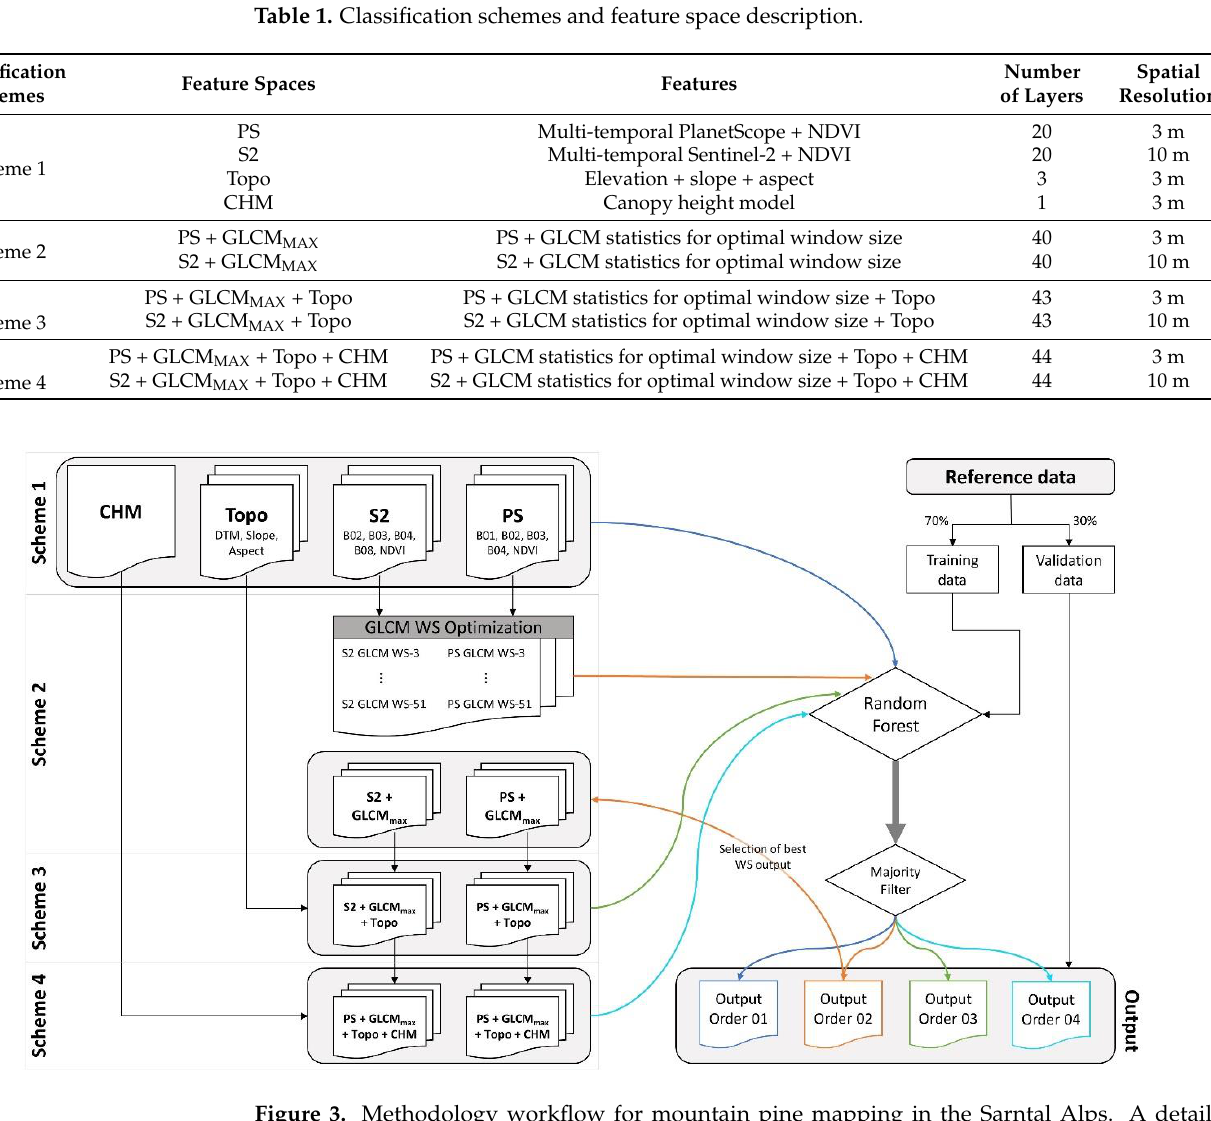
Figure 3. Methodology workflow for mountain pine mapping in the Sarntal Alps. A detailed de- scription of the different feature spaces is given in Table 1. Each individual feature space of the respective classification schemes is classified using a Random Forest model. A subsequent majority filter generates the respective final output for the different feature spaces for the four classification schemes. For identifying the optimal GLCM window size (WS) for PS and S2 feature space, each GLCM WS feature space is classified and validated. The GLCM WS feature space with the highest overall accuracy is chosen as GLCM MAX for PlanetScope and Sentinel-2, respectively.